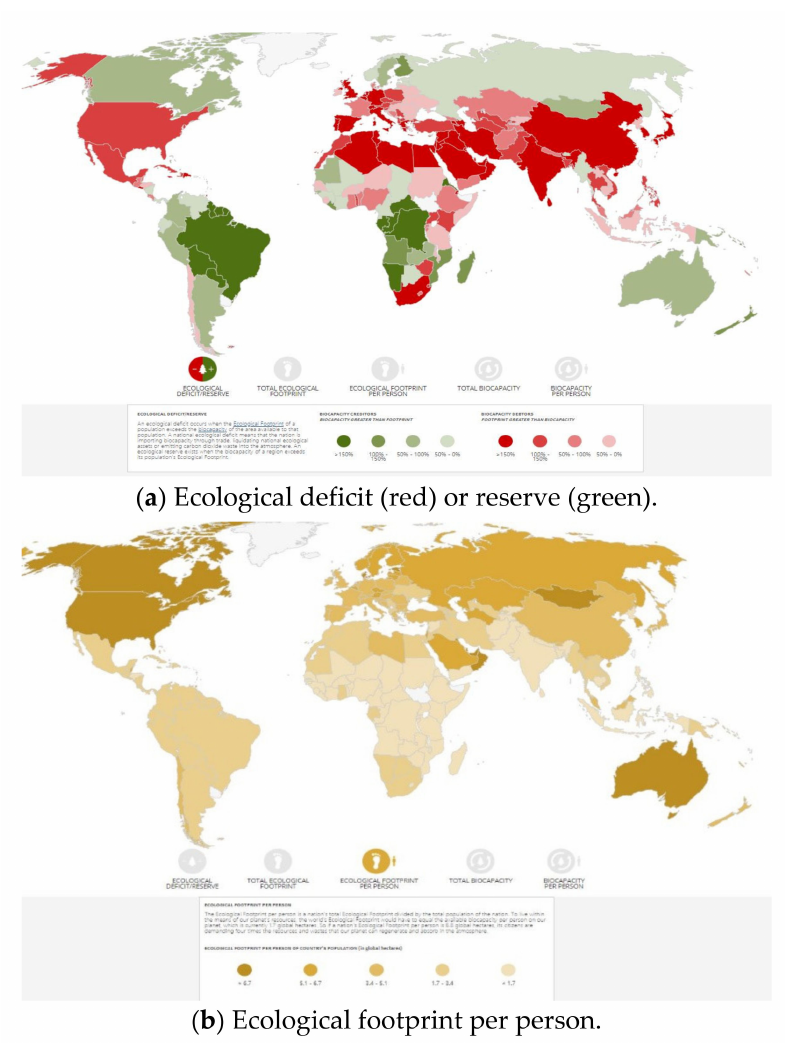
Figure 2. Ecological deficit and ecological footprint by